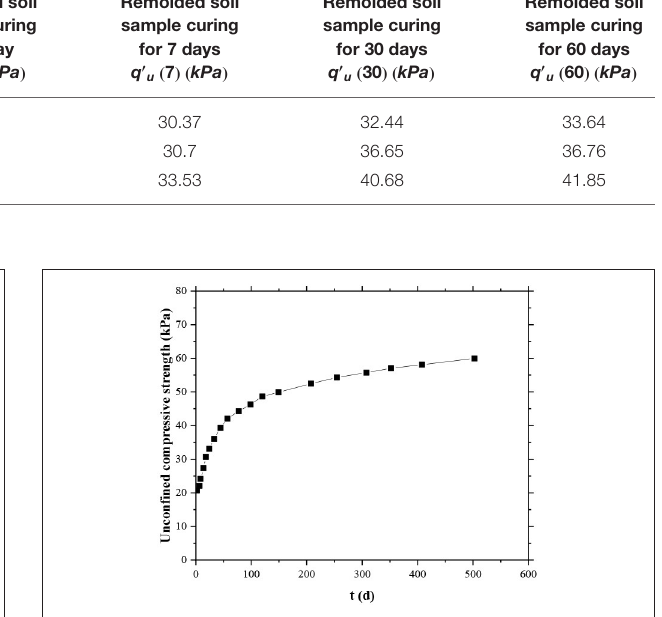
TABLE 3 | Unconfined compressive strength of undisturbed soil samples and remolded soil samples. Group